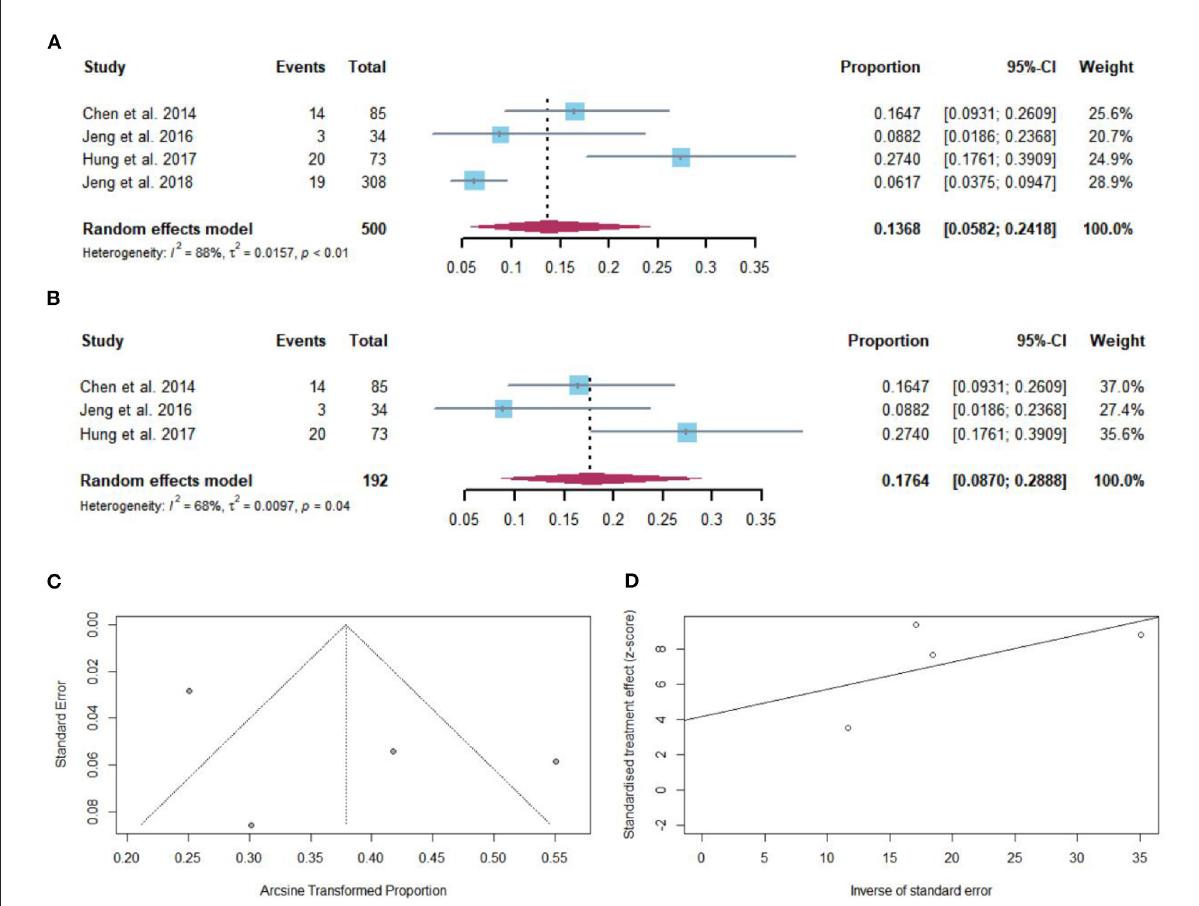
FIGURE5 (A) Individual estimates and pooled proportion of HBsAg loss in cirrhotic patients after NAs discontinuation. (B) Sensitivity analysis of pooled proportion of HBsAg loss in cirrhotic patients after NAs discontinuation excluding studies with high bias. (C) Funnel plot. (D) Egger’s